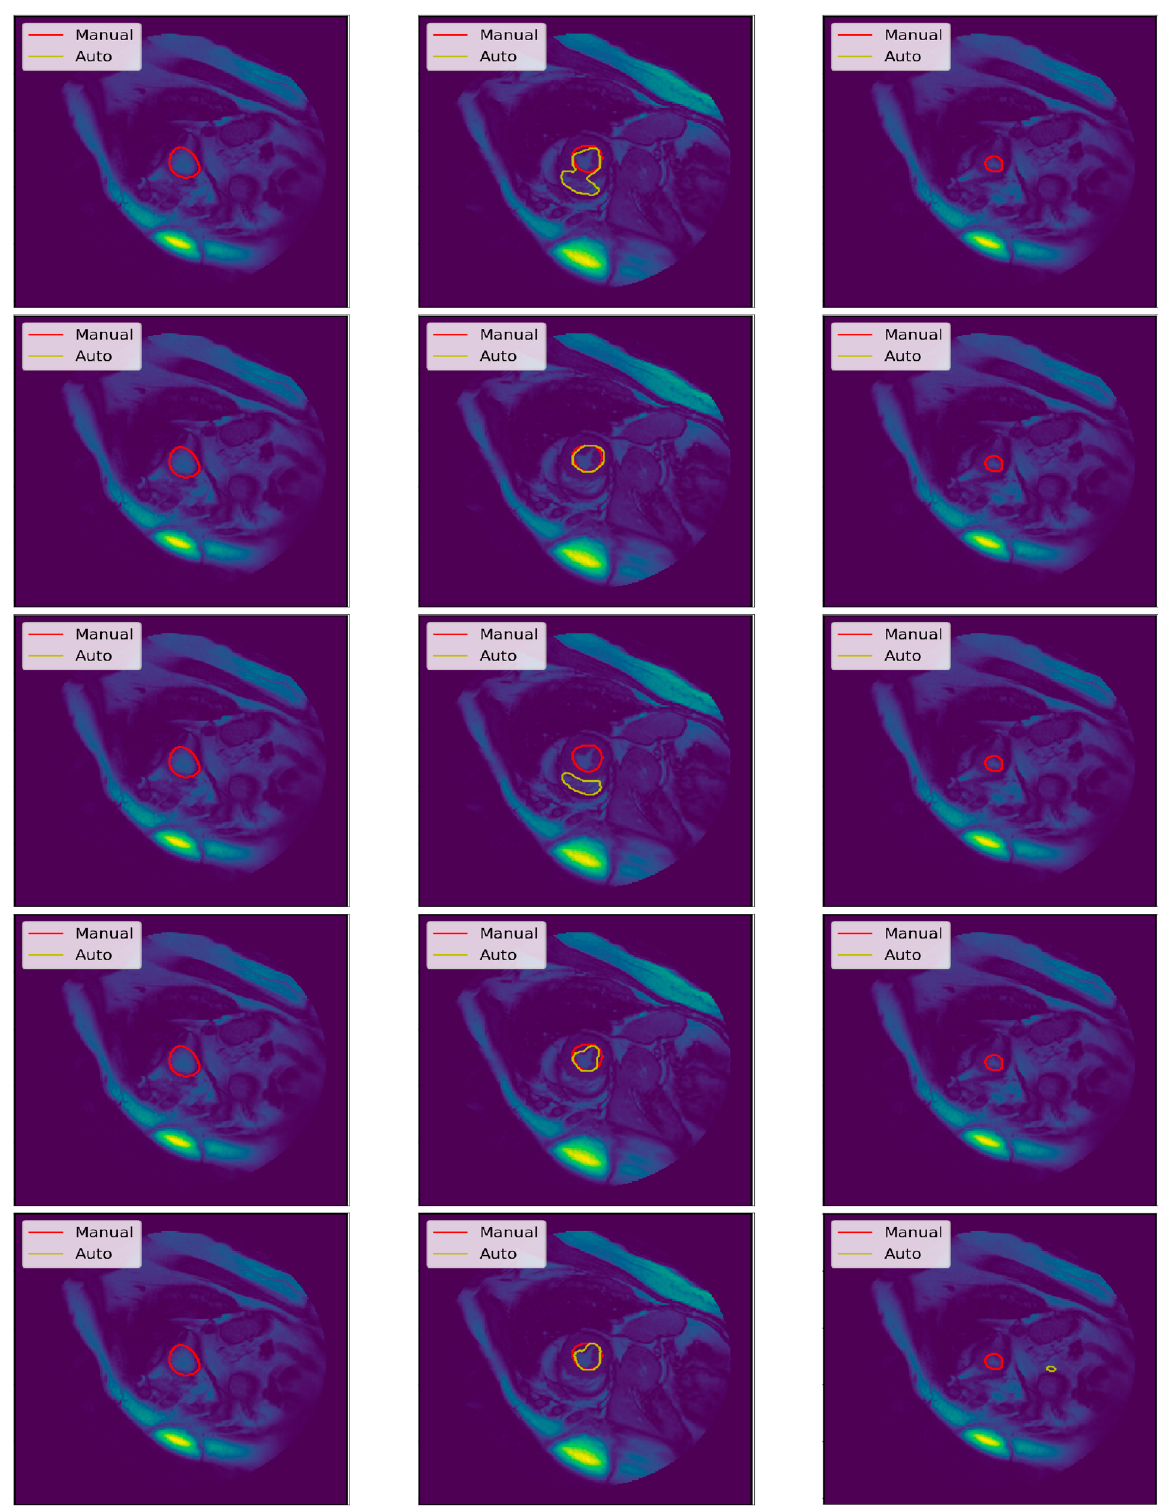
Figure 18. Misclassification in automatic segmentation when the cardiac cycle approaches the apical slices.